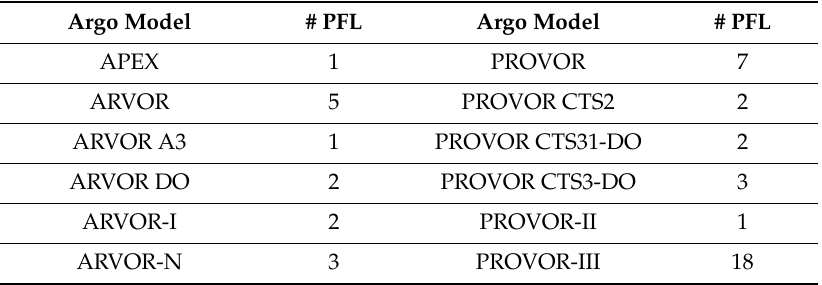
Table 1. Argo di ff erent models considered in the comparison vs. ship-based